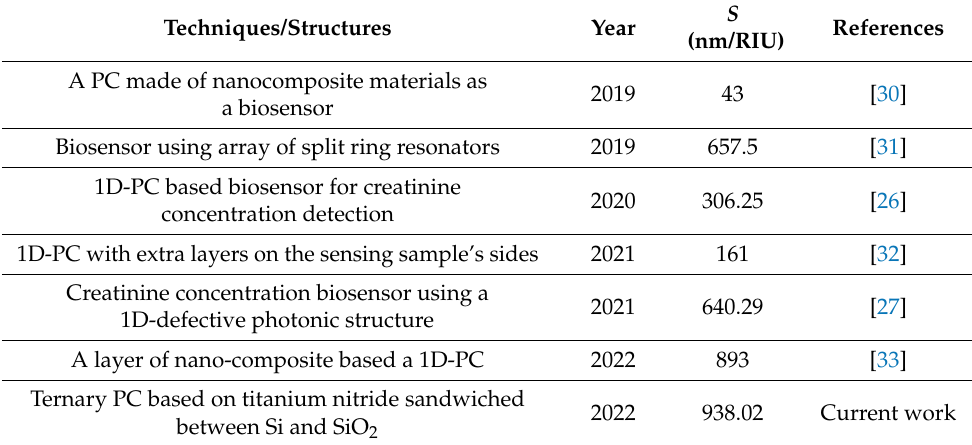
Table 6. The present study’s sensitivity in comparison to the most recent biosensors that have been